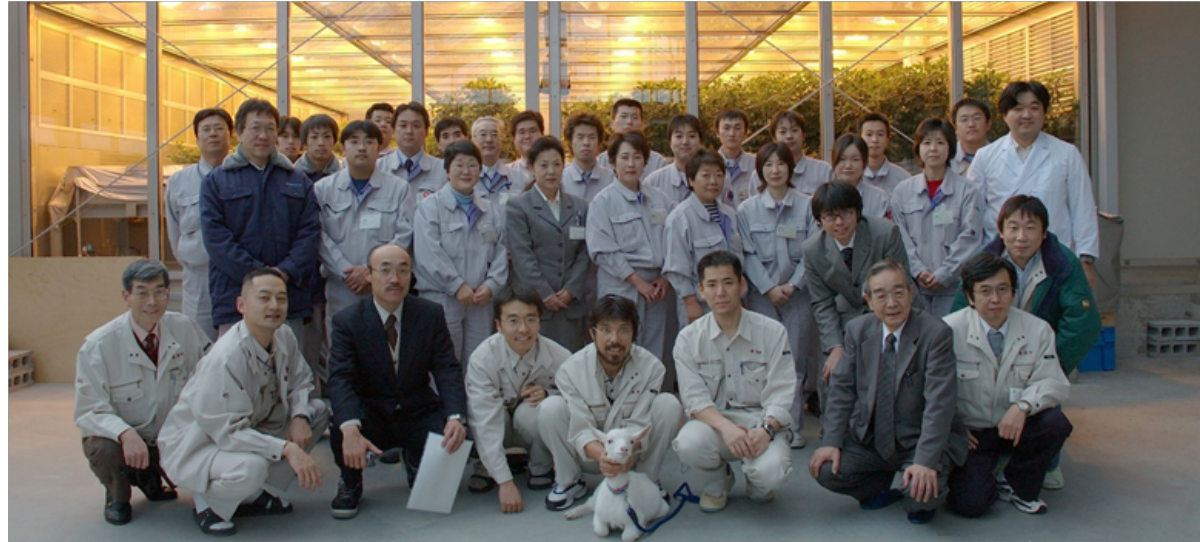
Figure 5 . Japanese Closed Ecological Experiment Facility (CEEF) team in 2005. Dr. Keiji Nitta, group founder and lead is second from the right in the front row, and Dr. Yasuhiro Tako, CEEF plant research lead is third from the left in the front row. CEEF was used to conduct a series of human life support tests where crops provided the O and water, and nearly all of the food for the two humans and two miniature goats (Tako 2 et al., 2008, 2010). Photo courtesy of Yasuhiro Tako, CEEF.